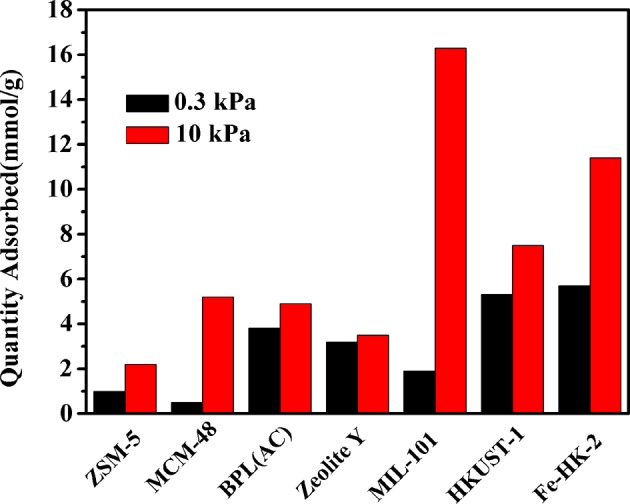
Adsorption capacity comparison of benzene on some adsorbents at same conditions.